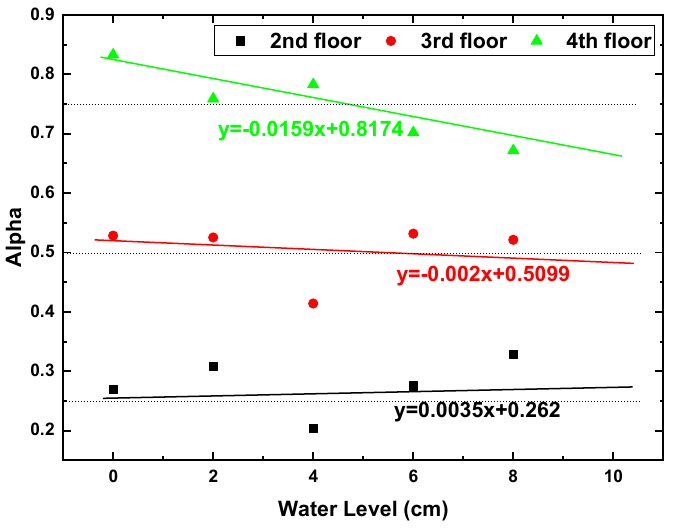
Figure 9. The ratio between the measured max acceleration amplitudes of top floor and tank floor.